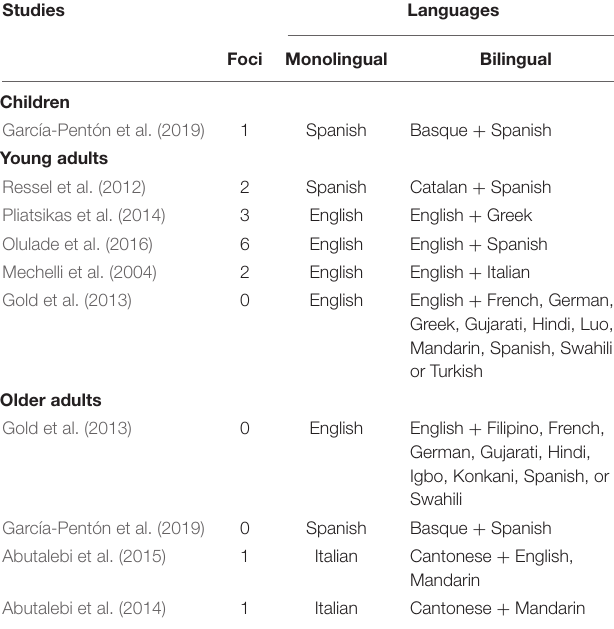
TABLE 2 | Number of foci and language